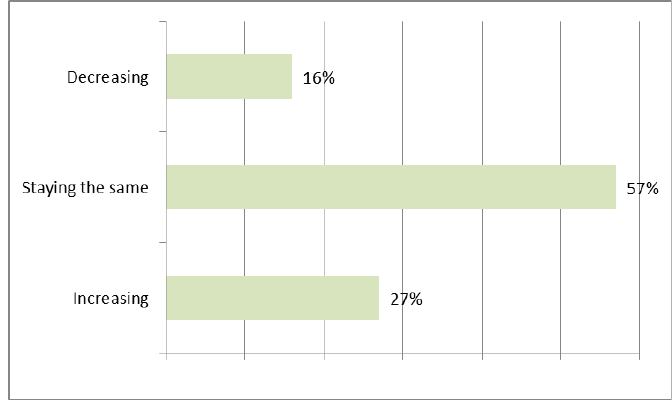
Figure 4. Evaluation of precast concrete elements — contractors.